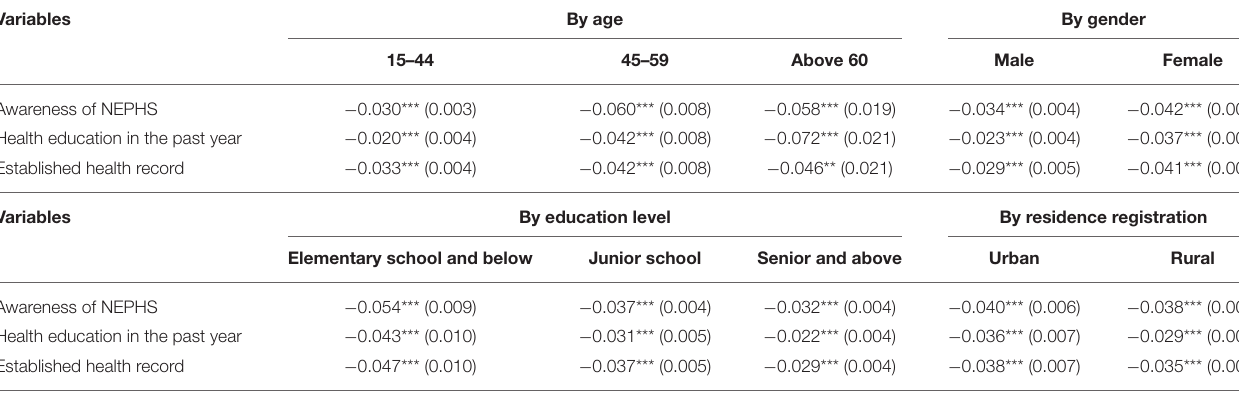
TABLE 5 | Heterogeneity analysis of the impact of NEPHS on health status. Variables By age